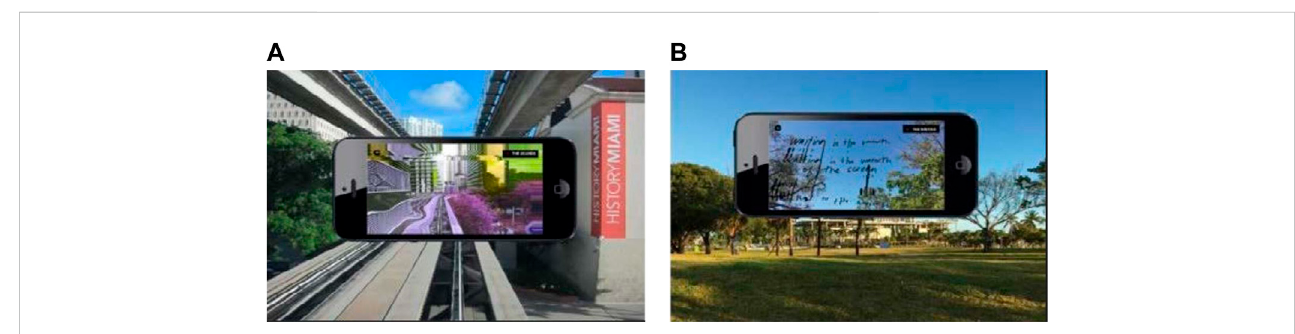
FIGURE 5 Berck (2017) which presents a number of ways that AR can affect urban planning, here the work of Depena (2016). Reproduced with permission from Depena (2016),